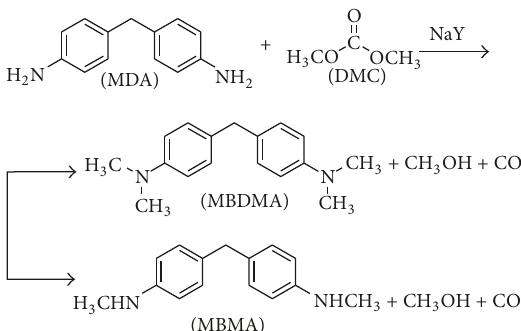
Scheme 1: Two possible N-methylation reaction pathways of MDA with